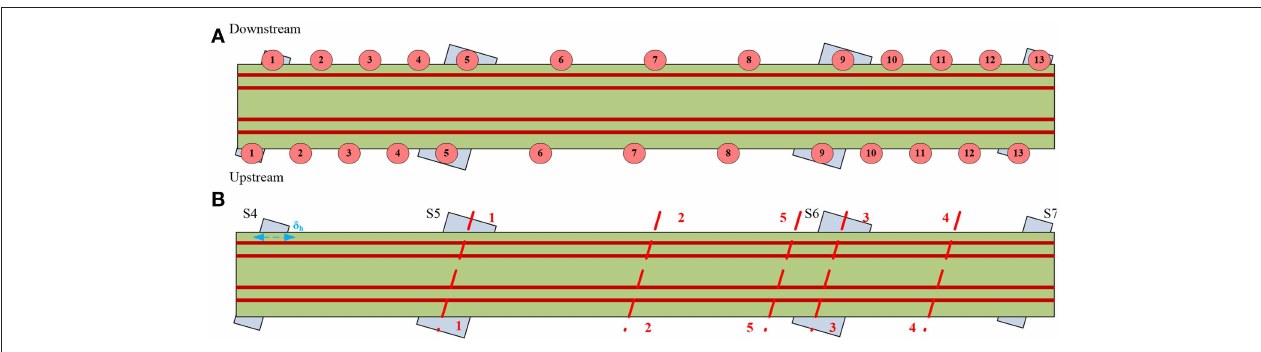
FIGURE 6 | Static load testing phases.